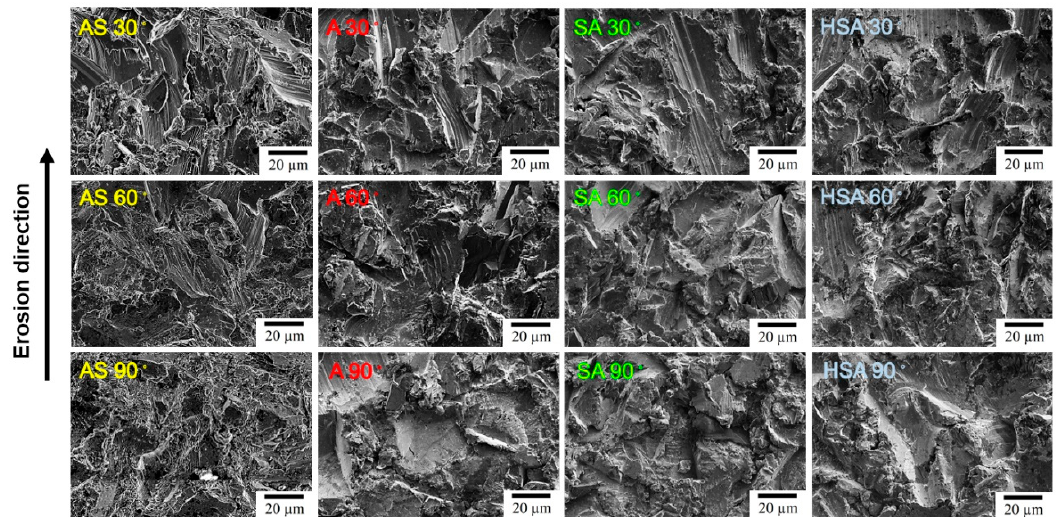
Figure 7. Surface morphology of AS, A, SA, and HSA at various impact angles.